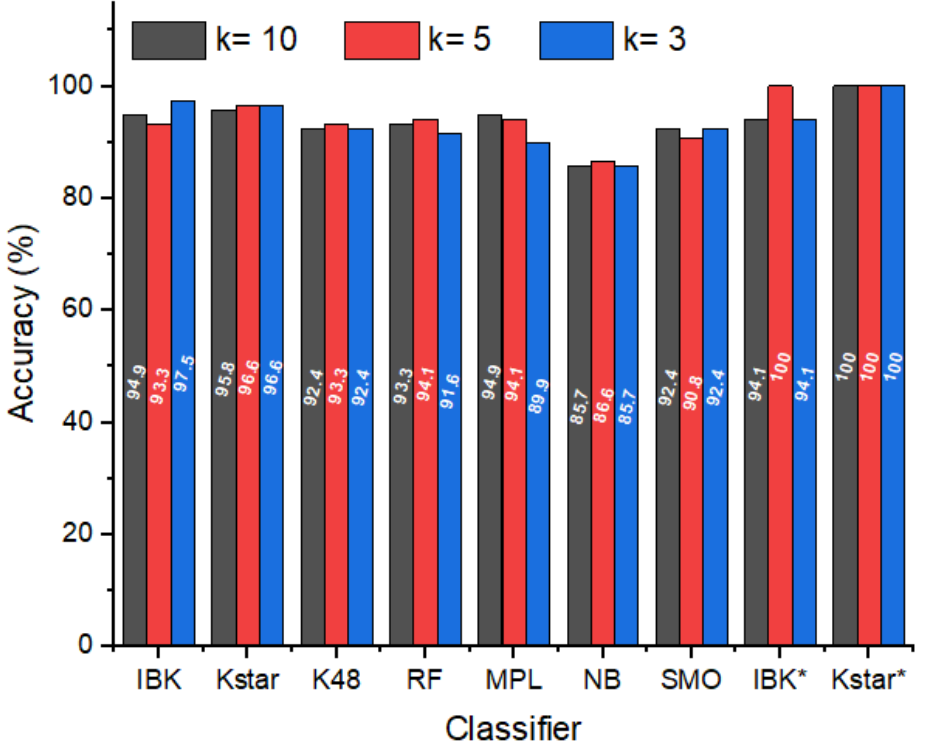
Figure 4. Comparison of accuracy obtained for different classifiers for discrimination between authentic and adulterated honey using individual cycle data (Table S1) and different values of k for the cross-validation (3, 5, and 10). * Classifiers using average sample data (Table 2).